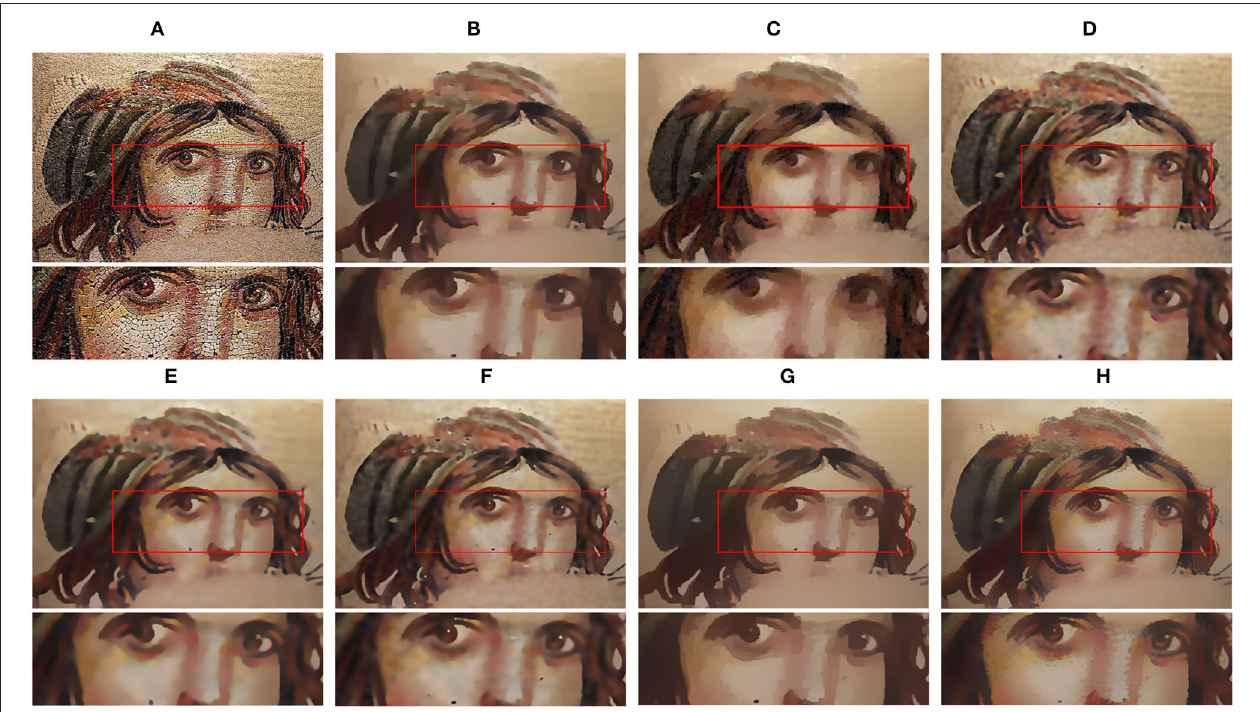
FIGURE 5 | Texture filtering results comparison. (A) Input image; (B) RTV ( λ = 0.015, σ = 8); (C) SGTD ( mu = 0.31); (D) RGF ( σ s = 5, σ r = 0.1); (E) BTF ( k = 9); (F) SATF ( sr = 0.1, se = 0.05); (G) ROG ( σ 1 = 1, σ 2 = 4); (H) ours ( σ r = 35, η = 10, I = 2). Reproduced with permission from Sanjay Ghosh, Ruturaj G. Gavaskar, Debasisha Panda and Kunal N. Chaudhury, available at https://sci-hub.wf/10.1109/TCSVT.2019.2916589.